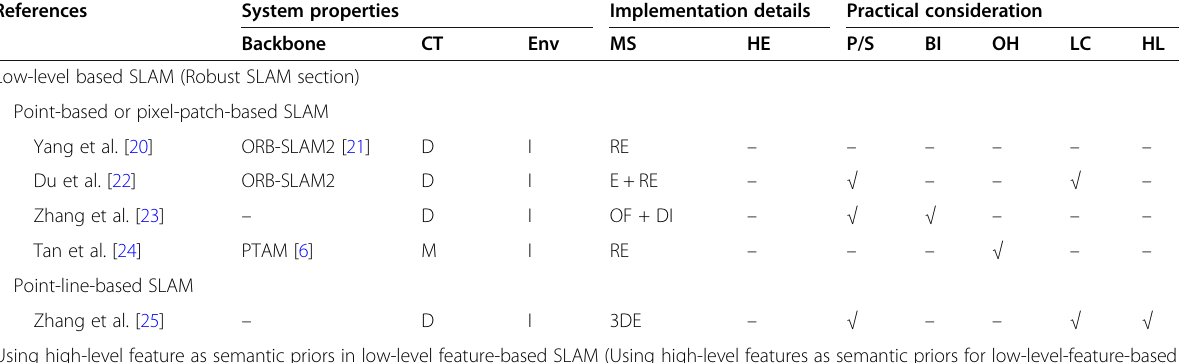
Table 2 Summary of recent robust SLAM